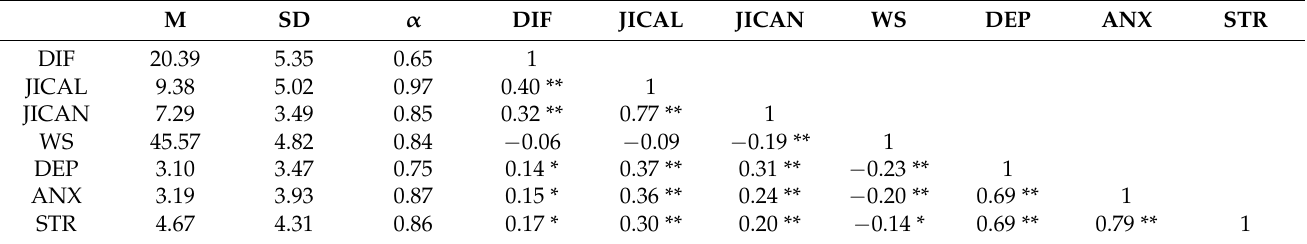
Table 1. Means, standard deviations, Cronbach Alpha coefficients, and correlations among variables.